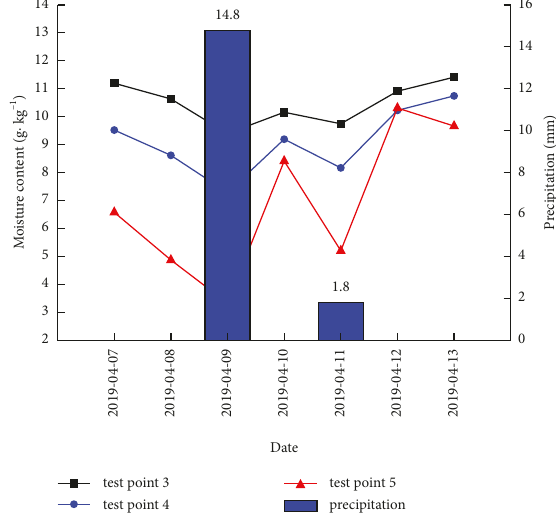
Figure 9: Average daily moisture content and precipitation inside the east